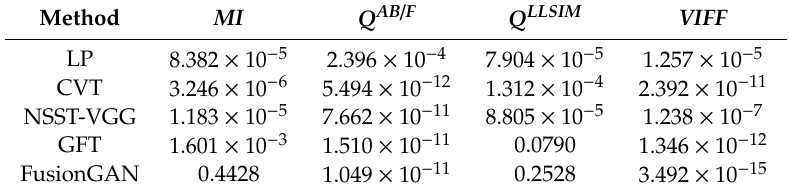
Table 2. p -values of the proposed method compared to other methods in di ff erent